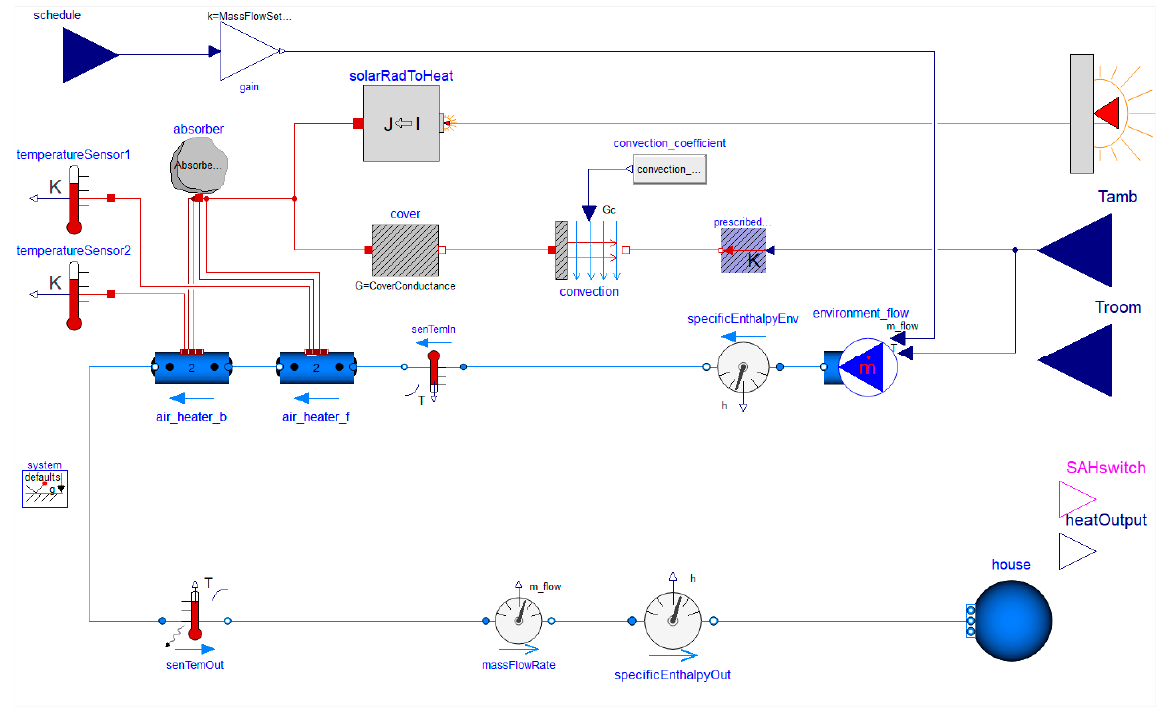
Figure 2. Graphical representation of the SAH model developed within the Dymola environment.